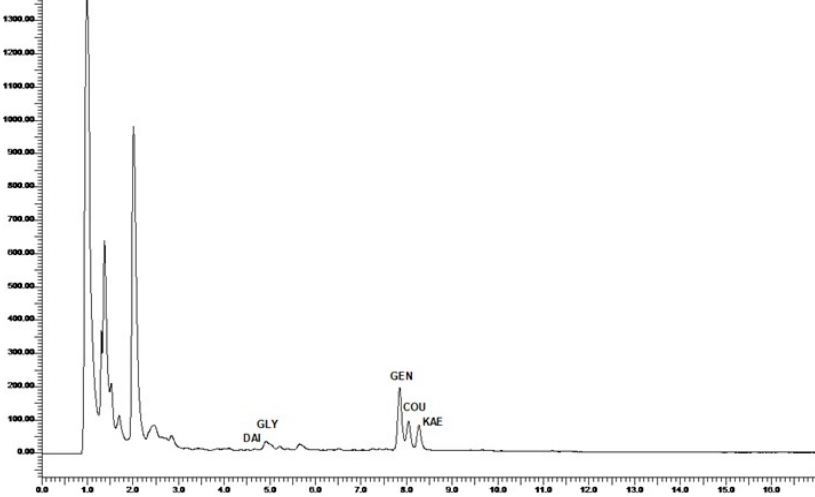
Figure 1. HPLC-DAD chromatogram of the phytoestrogens identified in alfalfa leaves extract